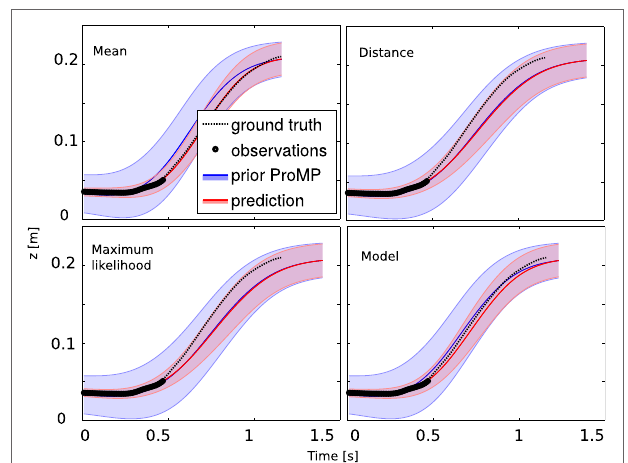
FIGURE 6 | The prediction of the future trajectory given n o = 40% of early observations from the learned ProMP computed for the test dataset ( Figure 2 ). The plots show the predicted trajectory, using different criteria to estimate the best phases of the trajectory: using the average time modulation (equation (11)); using the distance criteria (equation (13)); using the maximum log-likelihood (equation (12)); or using a model of time modulation according to the time variation (equation (14)).